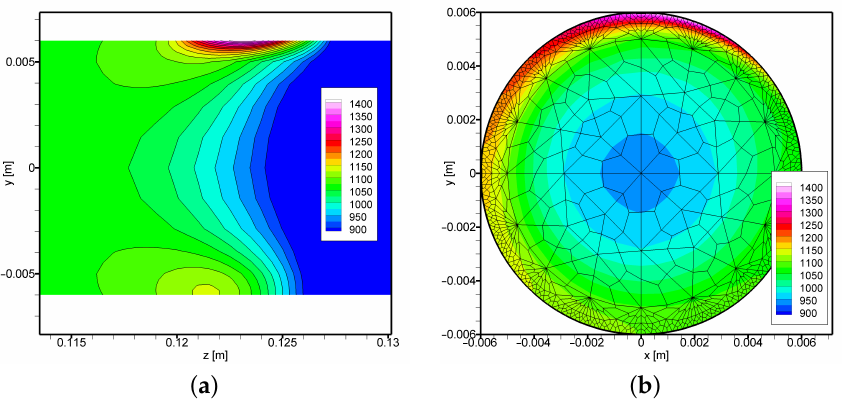
Figure 7. Temperature field in the cross-section: ( a ) longitudinal (x = 0 m), ( b ) transverse (z = 0.1235 m), in the area of maximum temperature ( t = 100 s, I = 80 A, ω p = 1